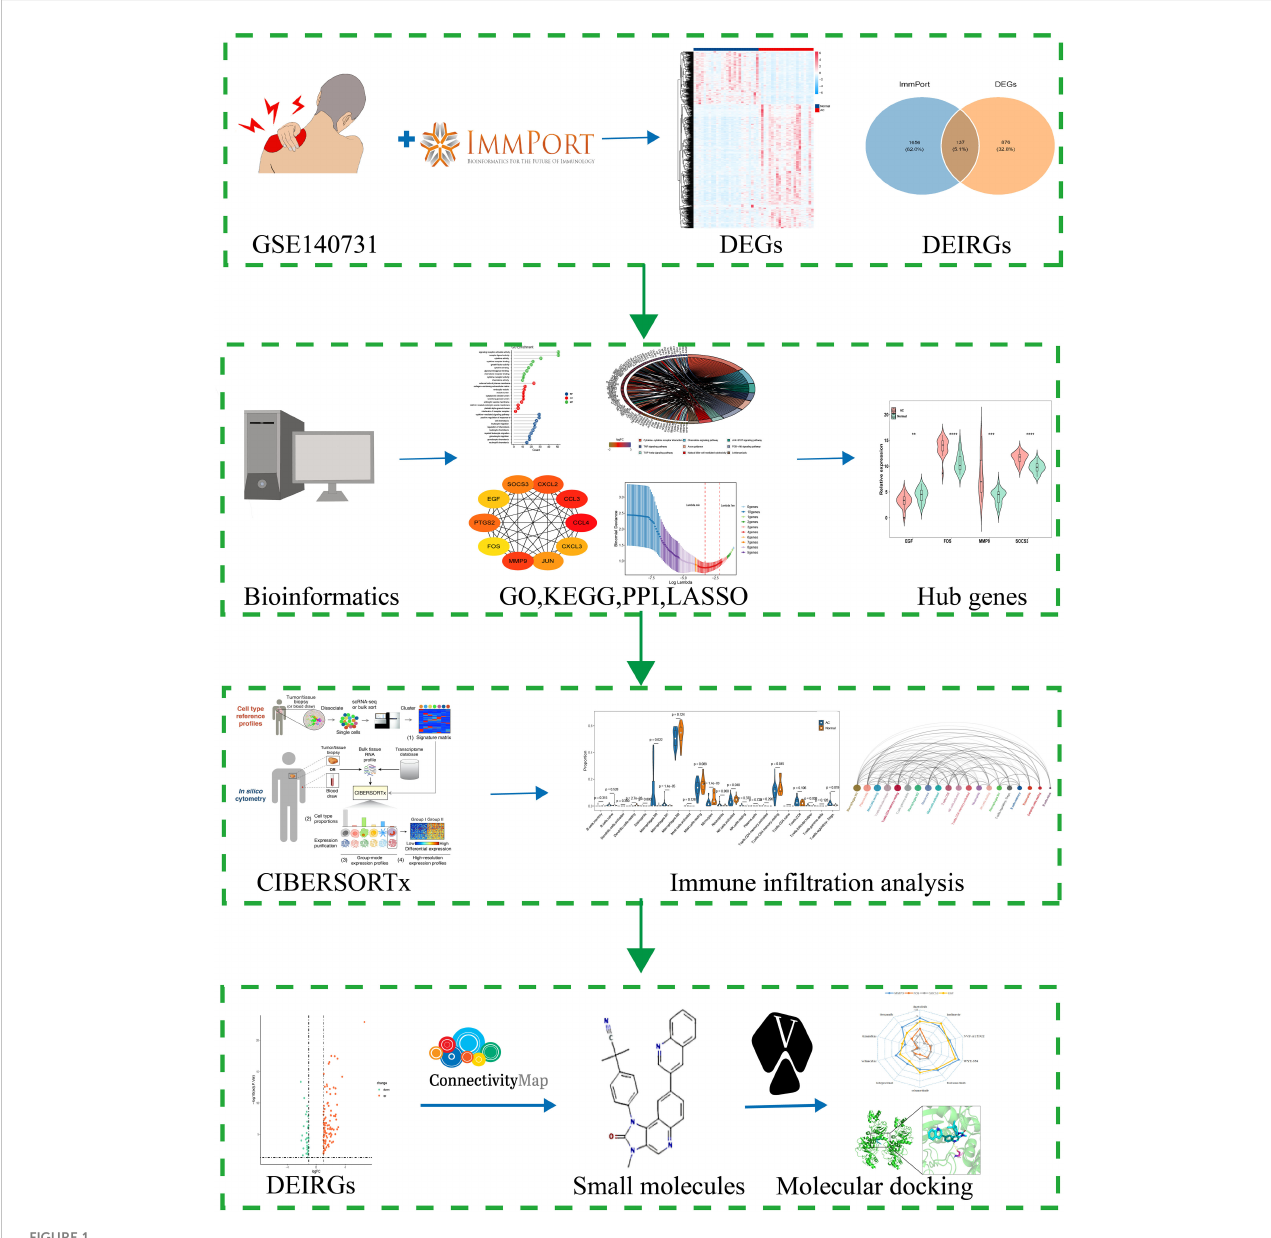
FIGURE 1 Flow chart of this study. **p<0.01,***p<0.001 and